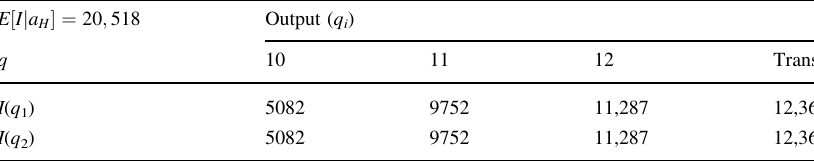
Table 6 Pay for performance using both divisions with transfer and transfer revealed E I a H j½ (cid:6) ¼ 20 ;